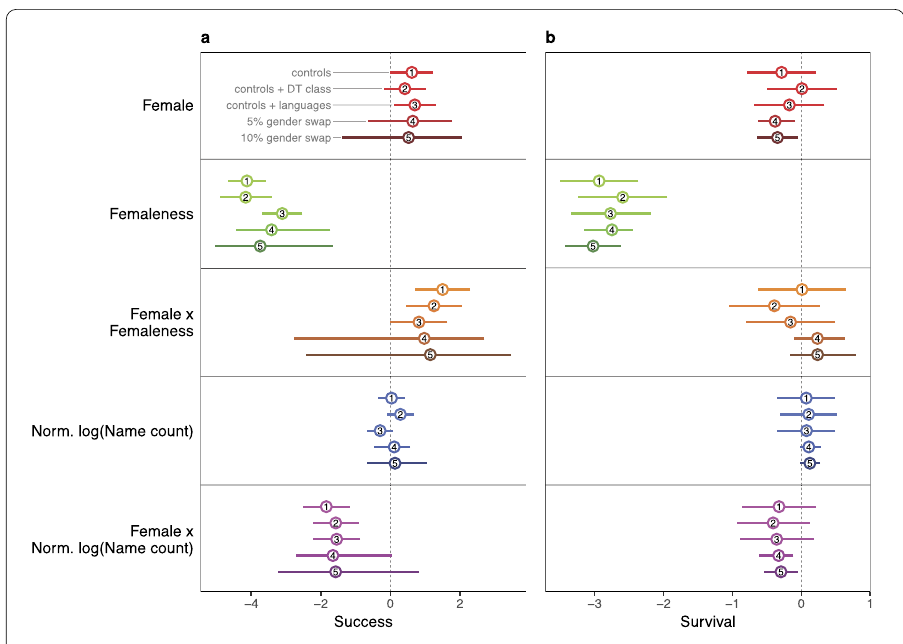
Figure 8 Point estimates, with 95 percent CIs, for variables related to gender (variables are listed on the vertical axis). Panel ( a ) shows coefficients from count models of zero-inflated negative binomial models predicting success (the number of stars received), while panel ( b ) shows log odds ratios from logit models predicting survival over a one year period following our data collection. Labels of five specifications (identical for success and survival models) are shown in the legend. The first model enters gender variables and controls, the second enters controls and categorical gender behavior classes from the decision tree analysis, the third enters controls and 23 variables recording programming language use. The fourth is identical to the first, but with data with 5 percent gender swaps, and the fifth is with 10 percent gender swaps. For the fourth and fifth models confidence intervals show the 2.5–97.5 inter-quantile range from 100 simulated datasets